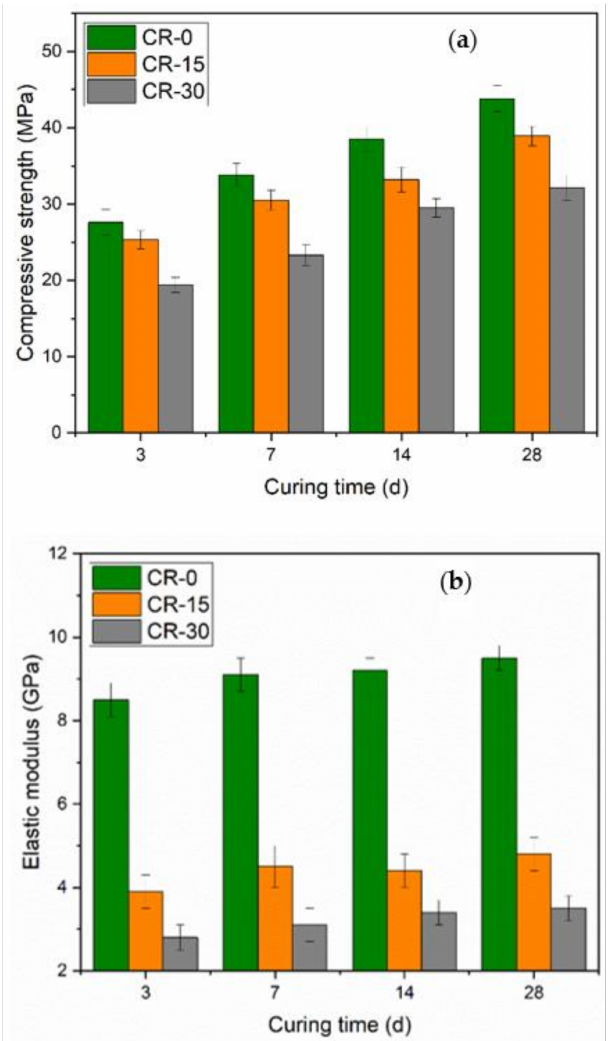
Figure 5. Mechanical properties of resin-modified cement-based composites (( a ). compressive strength; ( b ). elastic